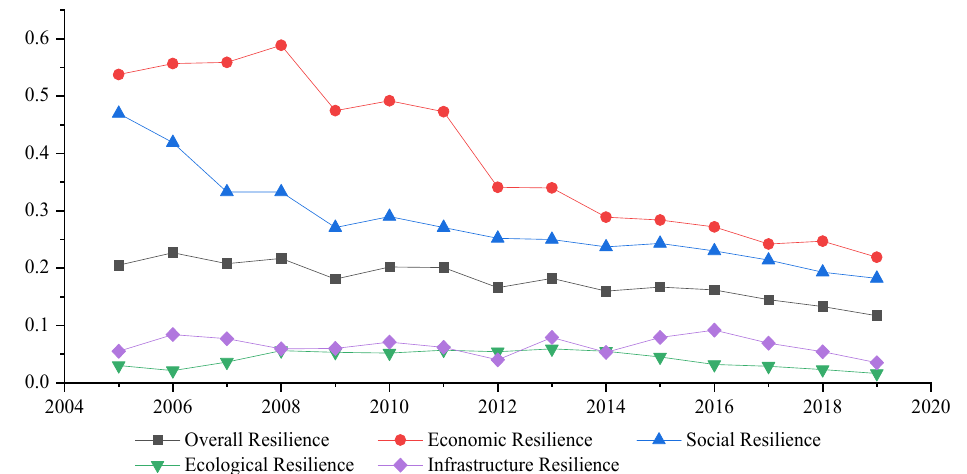
Figure 4. Theil index of urban resilience in the Chengdu–Chongqing urban agglomeration from 2005 to 2019.